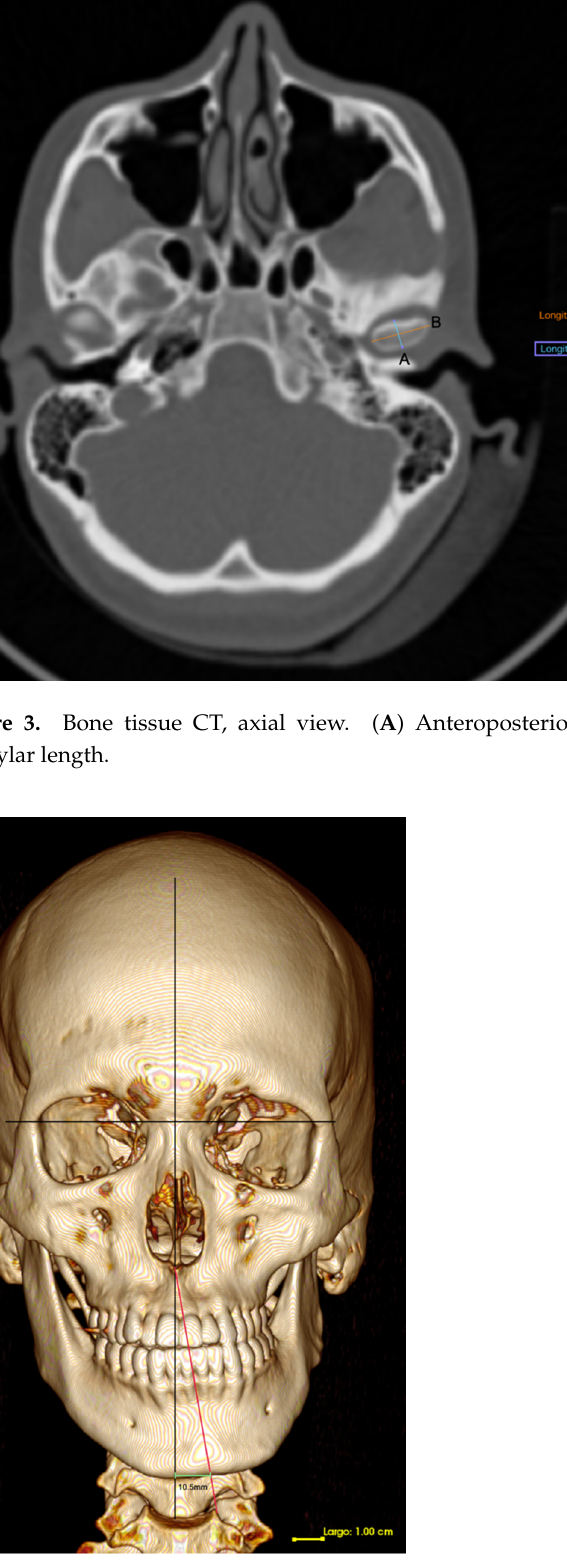
Figure 4 . Bone tissue CT, 3D reconstruction. Coronal view. Mandibular deviation magnitude and deviation side.